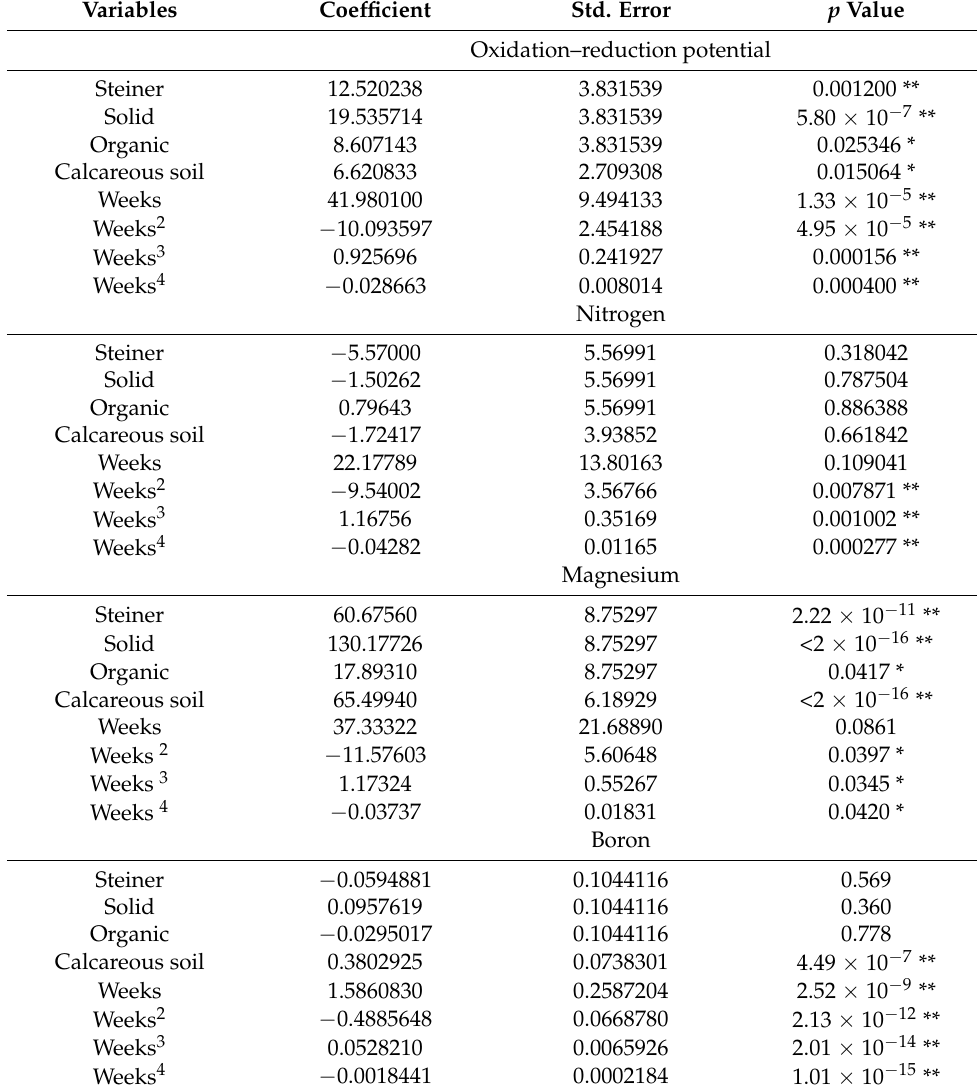
Table 9. Multiple linear model between the potential oxidation-reduction, nitrogen, boron, and three variables: two explanatory variables (treatment and soil type) and one numerical variable (weeks) of quartic degree. The reference treatment for the comparison of the different nutrient contribution scenarios was irrigation water, while the forest soil was used as a reference to compare it against the calcareous